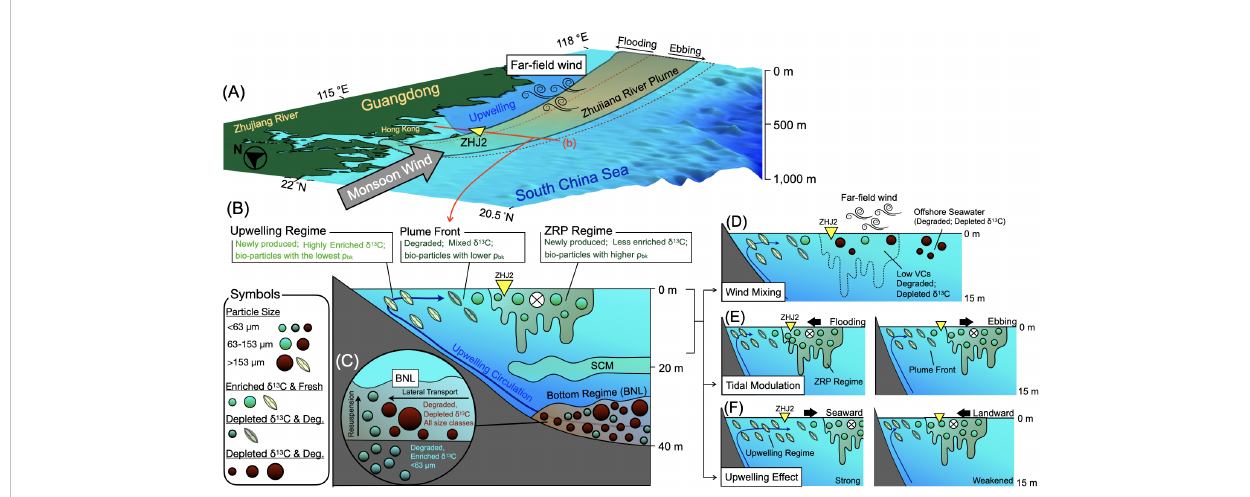
FIGURE 13 A schematic diagram illustrating process-response relationships among the physical forcing and types of SPs, including (A) The bird ’ s view of the physical forcing includes the southwesterly monsoon wind, tidal modulations, and far- fi eld wind along the propagation pathway of the ZRP. (B) Along the transect in (A) shows regimes entraining SPs in the water column (the transect in (A) is marked “ (B) ” ). The characteristic of each regime is described in the box above the (B) . Different symbols on the left indicate the types of particles. (C) The circle shows an enlarged BNL. The cause- and-effectiveness between the physical forcing and SPs in the upper water column is on the right, such as (D) the mixing induced by the far fi eld wind, (E) the tidal modulations, and (F) the upwelling-associated effect. The inverted yellow triangle indicates the location of ZHJ2.